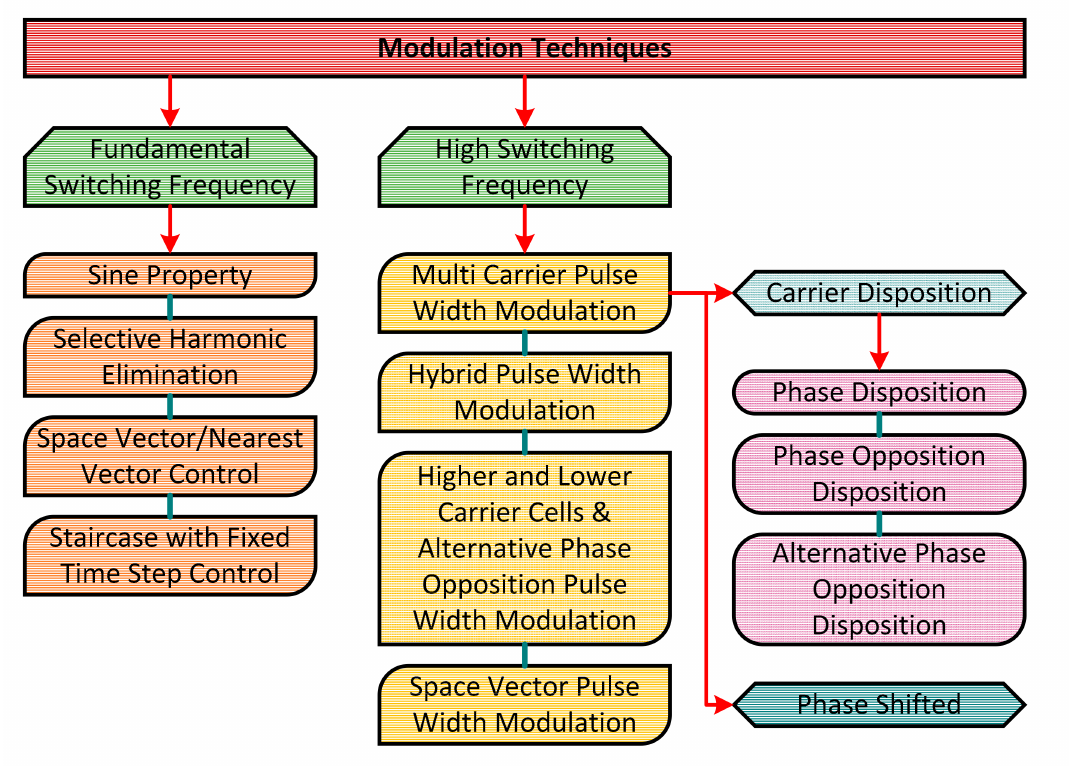
Figure 26. Categorization of modulation schemes for multilevel